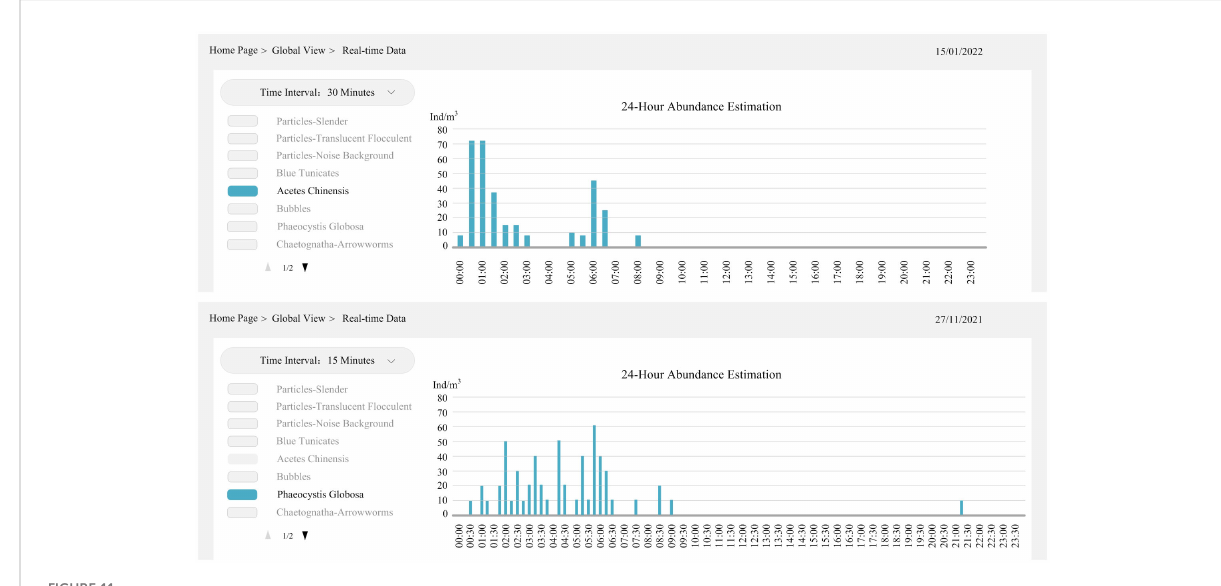
FIGURE 11 24-hDCO abundance estimation of Acetes chinensis and Phaeocystis globosa